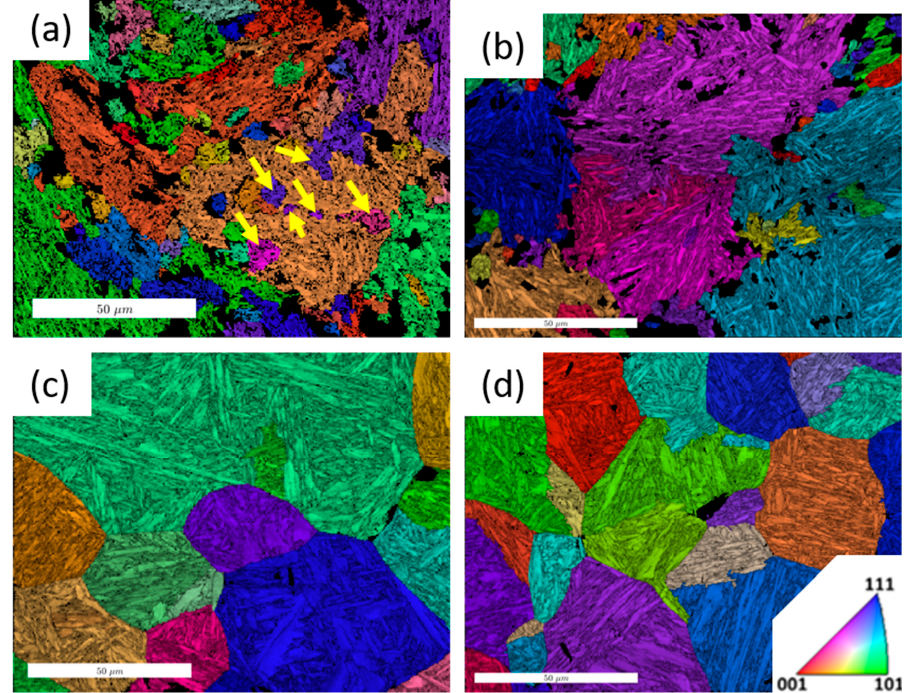
Figure 4. Reconstruction results depicting austenite grains and their orientations for ( a ) N H Q L , ( b ) N L Q L , ( c ) N H Q H , ( d ) N L Q H samples. The austenite regions in ( a ) indicated by yellow arrows have KS variants in common with the surrounding austenite region, to within 5° misorientation.